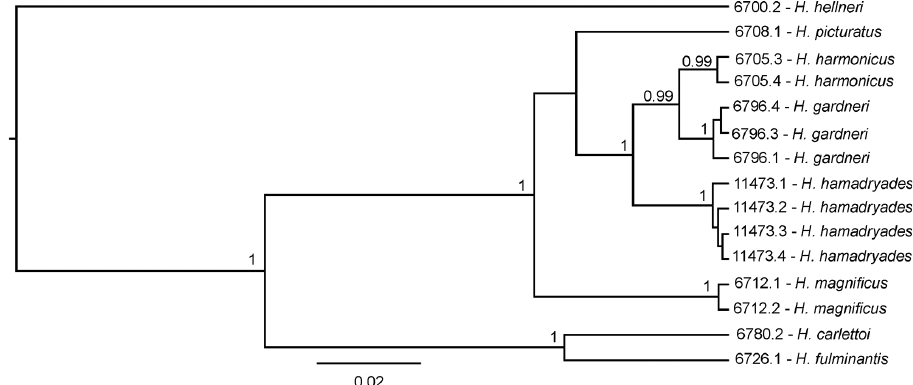
Figure 1. Bayesian phylogeny used to delimit species of the Hypsolebias magnificus complex inferred by using sequences of the mitochondrial gene cytochrome b, 463 bp. Numbers above nodes are posterior probability values above 95 %; numbers before species names are catalogue numbers for